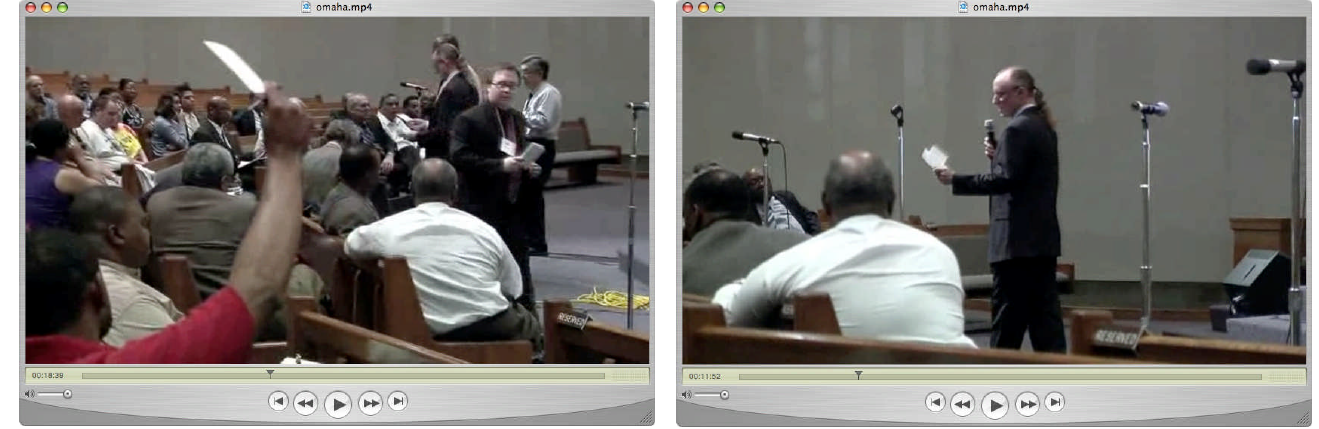
Figure 7: Audience member submitting Figure 8: Bob Peters (facilitator) with Question Card & Helper approaching mic reading (controlling) a Question